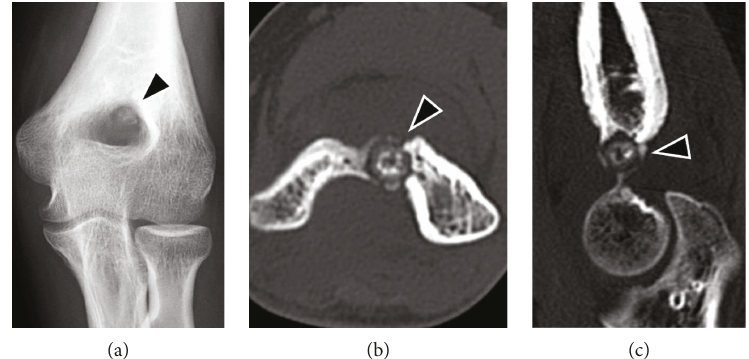
Figure 2: Preoperative radiographic images. The anteroposterior radiograph (a) and computed tomography images (b: axial, c: sagittal) depict a nidus comprising central sclerosis with circumferential radiolucency (arrowhead) at the olecranon/coronoid fossa of the